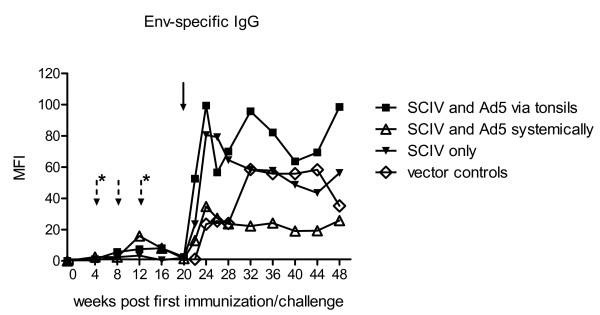
IgG response to the viral env-proteins. During vaccination, SIV-specific IgG antibodies targeting the envelope were determined in all vaccine groups and in the control group after challenge with SIVmac239. For this assay SIVmac251 infected HSC-F were incubated with heat-inactivated sera from vaccinated and infected animals. SIV-specific antibodies bound to infected T-cells were stained with a FITC-labelled anti-human IgG and determined by flow cytometry. Values are given as mean fluorescence intensities (MFI). Dotted arrows mark points in time of boosts and additional asterisks refer to boosts of group 1 only, whereas the black arrow indicates the point in time of challenge.